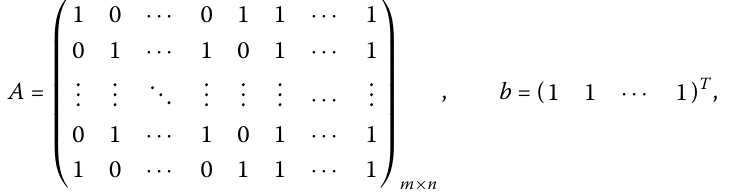
and τ = 2. In this example, we choose m = 30, n = 100. The numerical results are given in Figs. 3 and